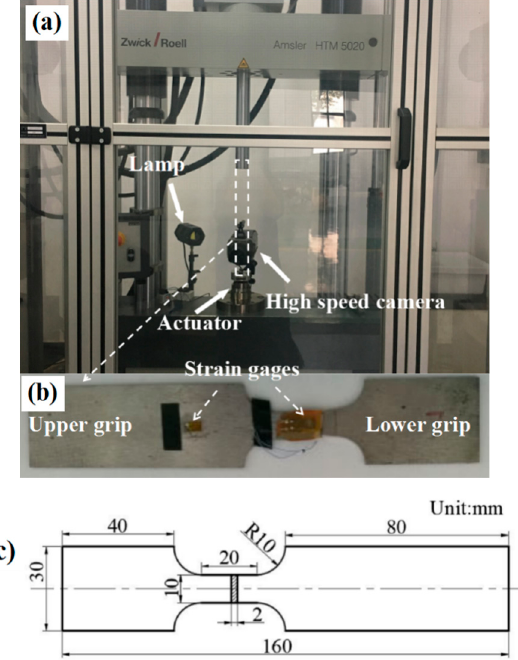
Figure 2. Dynamic tensile testing setup of ( a ) Amsler HTM 5020 testing system, ( b ) Specimen attached with strain gages and ( c ) Specimen dimensions (unit: mm).